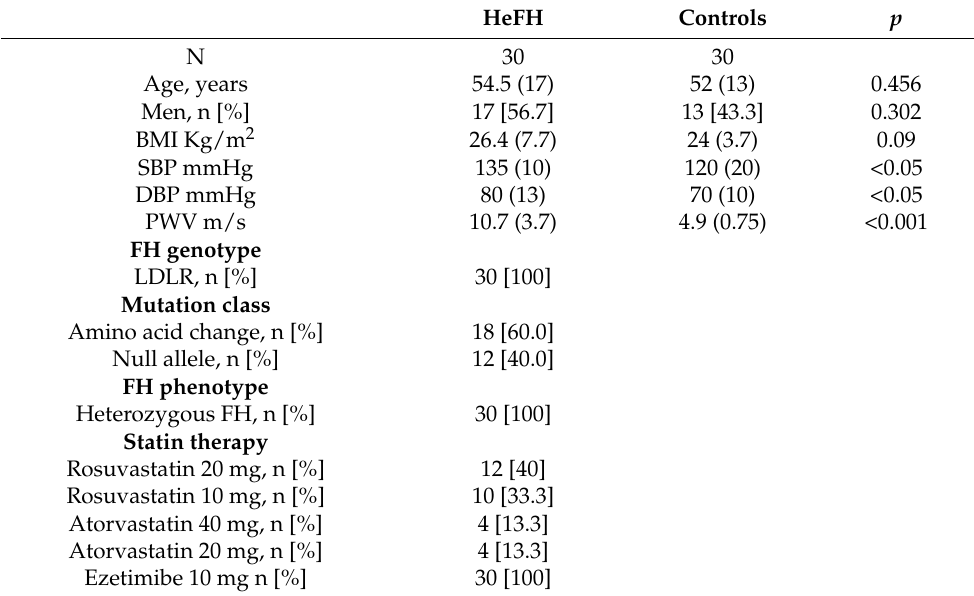
Table 1. Characteristics of the study